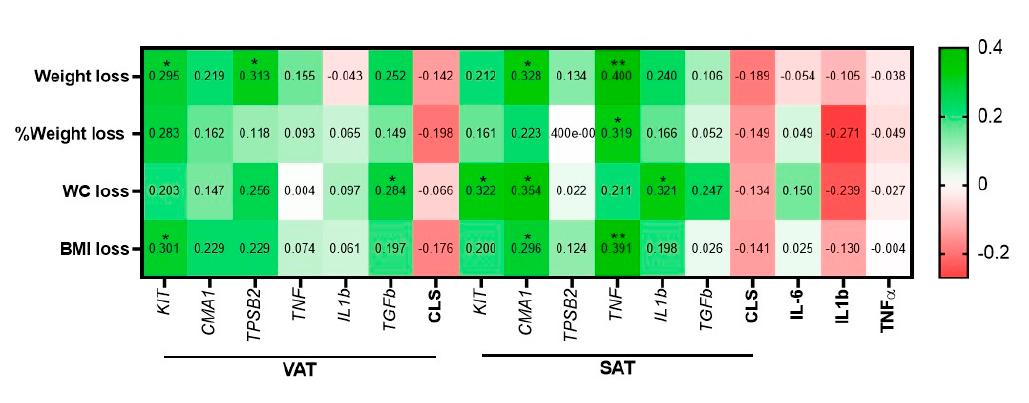
Figure 6. Correlation between baseline parameters and 1 year postoperative weight loss response in validation cohort 2. Values are r ( ρ ) of Spearman’s correlations. WC: waist circumference. * p < 0.05; ** p < 0.01.